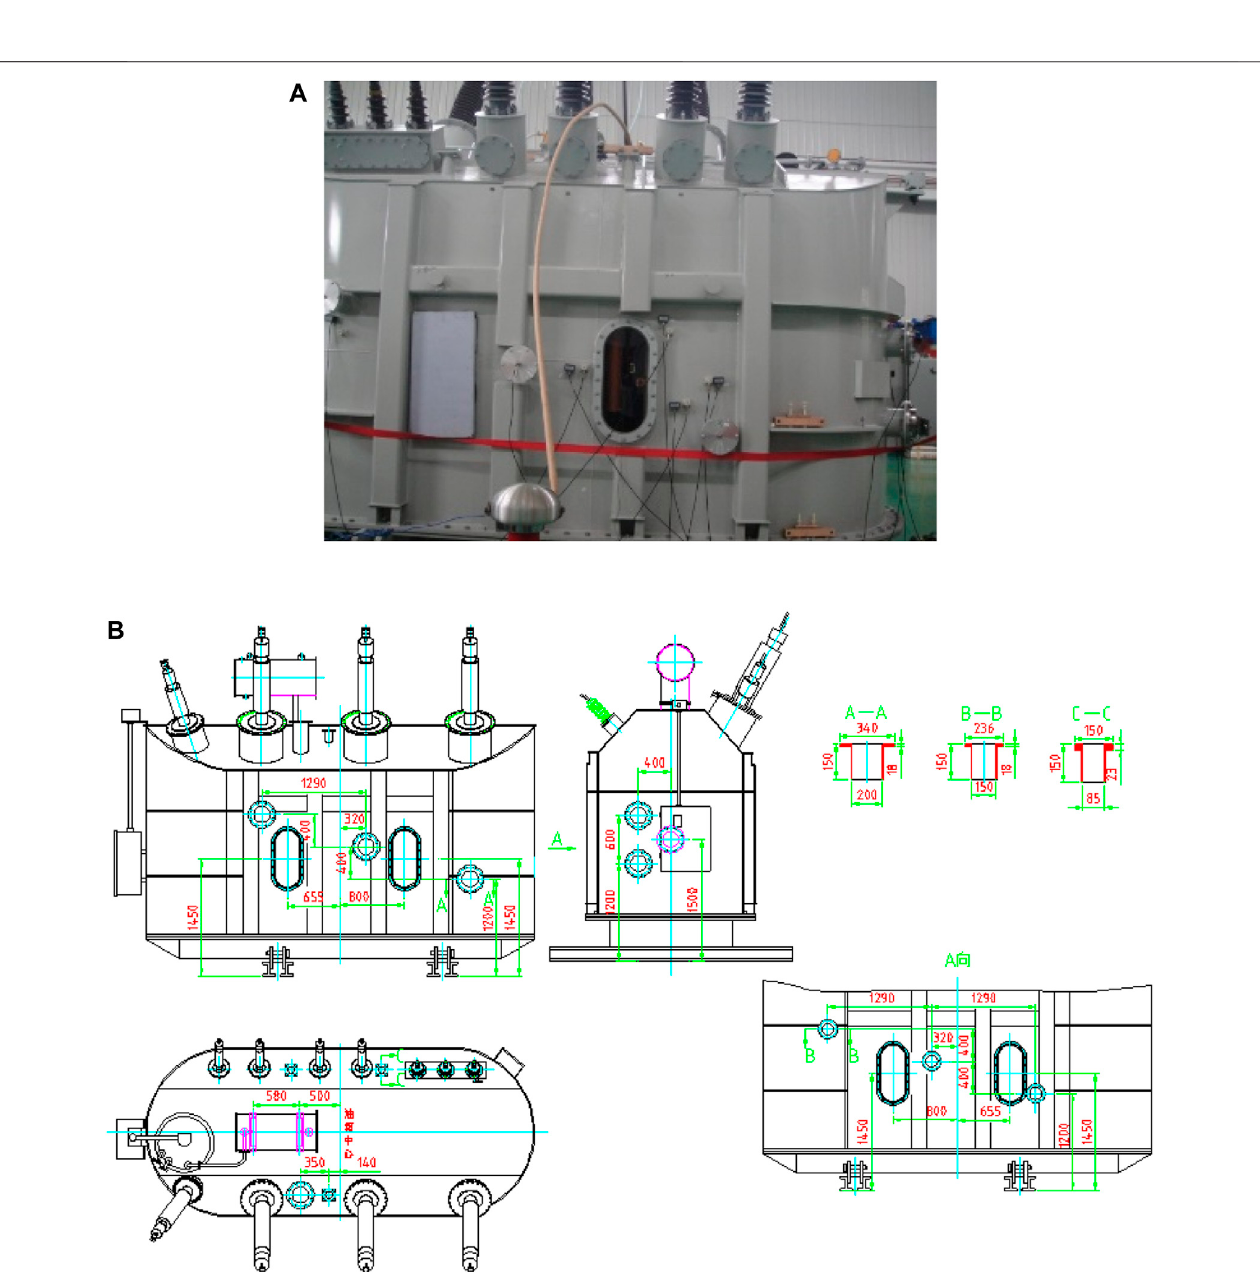
FIGURE 7 | Field experiment transformer. (A) Photos of transformer (B) Size and structure.